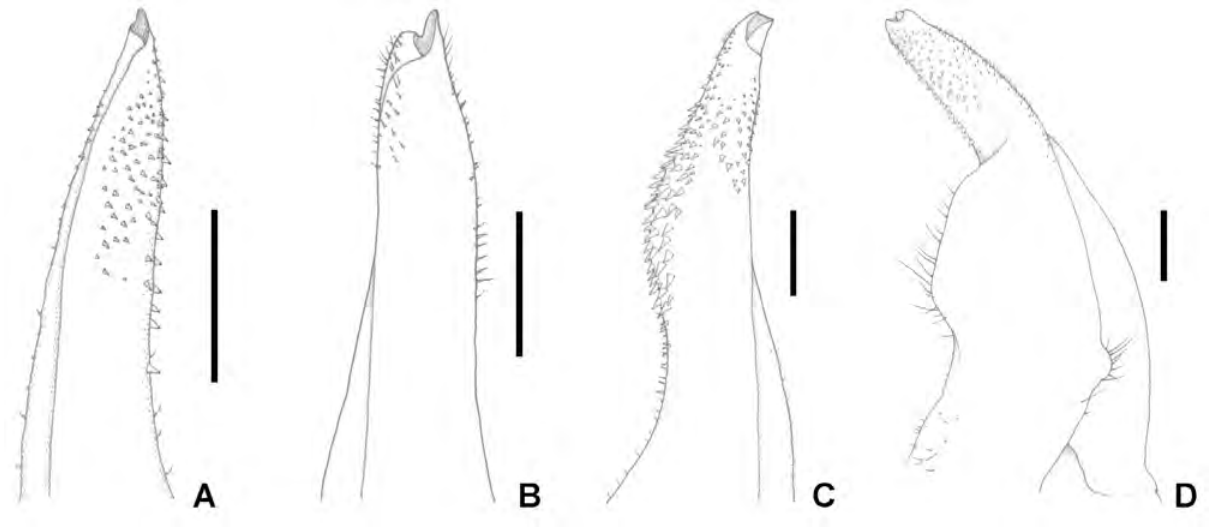
Figure 2. Male first gonopod, right side, of the trichodactylid crabs from Roraima. A, Moreirocarcinus laevifrons (Moreira, 1901), distal part, mesial view, INPA 1493; B. Poppiana dentata (Randall, 1840), distal part, mesial view, INPA 1896; C, Sylviocarcinus pictus (H. Milne Edwards, 1853), distal part, mesial view, INPA 1900; D, Valdivia serrata White, 1847, whole limb, mesio-caudal view, INPA